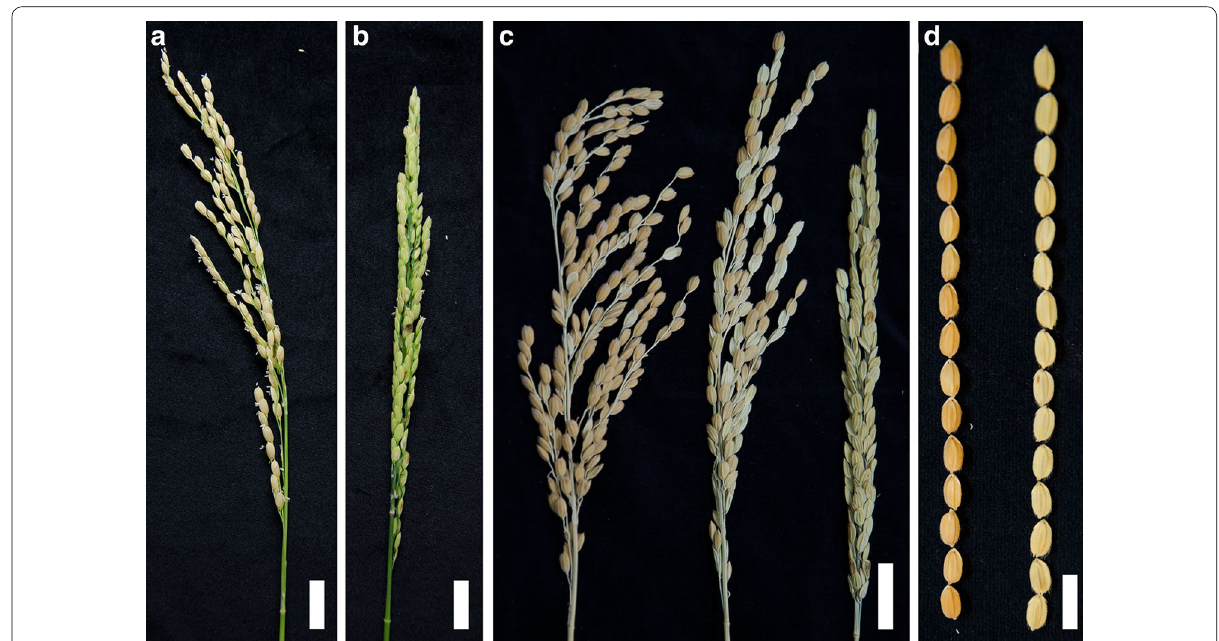
Fig. 1 Phenotypic characterization of segregants of the semi‑sterile mutant ( sstl ). a Plants with fertile panicles; b completely sterile panicles; c three types of fertility in the sstl progeny segregates: from left to right as fertile, semi‑sterile, and sterile. Bar indicated. Bar